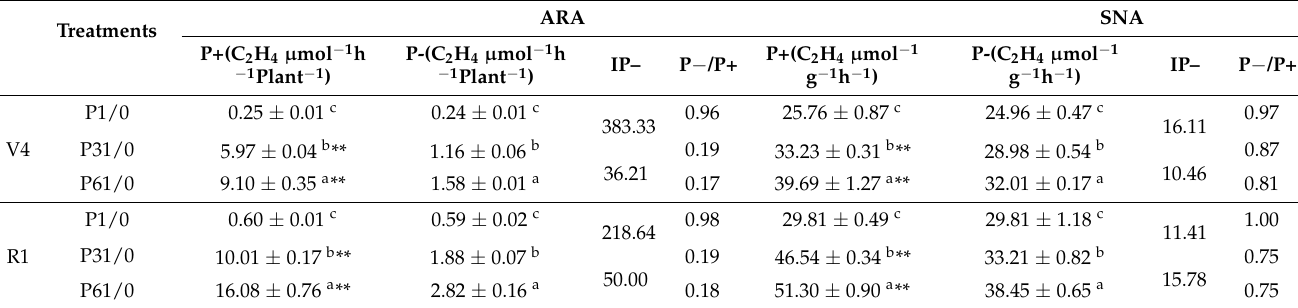
Table 3. Effects of P supply on ARA and SNA in dual-root